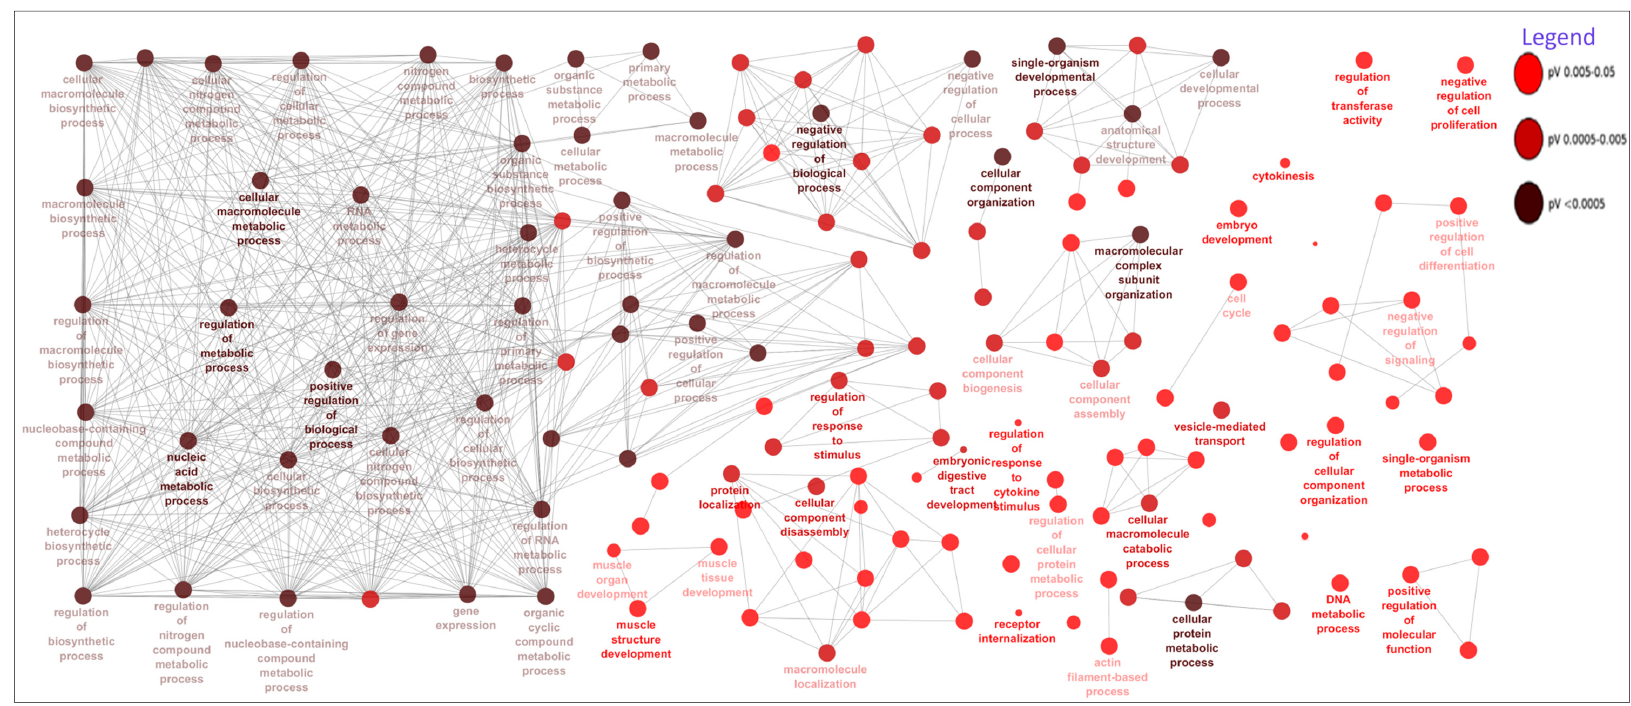
Figure 2. The ClueGO results for biological processes gene ontology terms enrichment for target genes (mRNAs) of differentially expressed miRNAs and relationships between them. The nodes (round shape) represent gene ontology terms, node color represents the level of significance as indicated in the legend, while node size reflects the number of genes enriched in each gene ontology term.